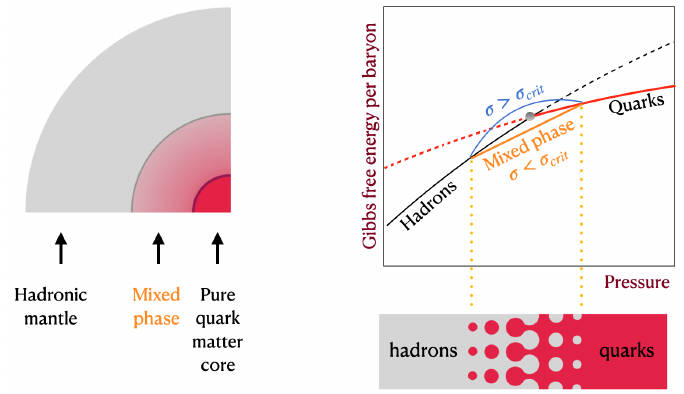
Figure 2. Same as in the previous figure but for a mixed